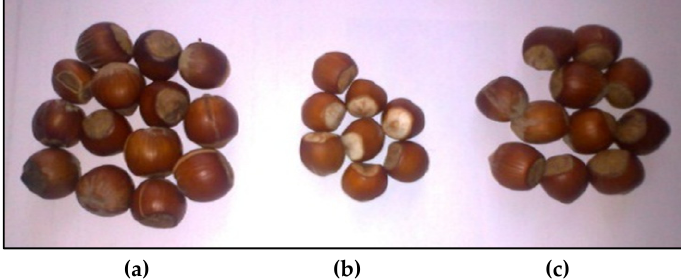
Figure 3. ( a ) Hollow or damaged hazelnut for two size; ( b ) small intact and ( c ) big intact hazelnuts. Table 1. Mean dimensions of 100 samples of each group of hazelnuts. Length Width Thickness Mean